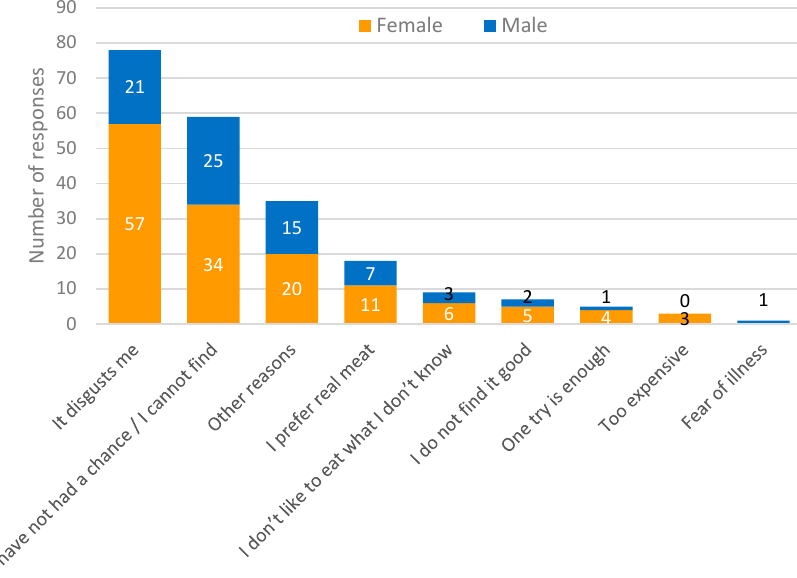
Figure 4. Reasons for never having eaten insect food or having eaten only once .